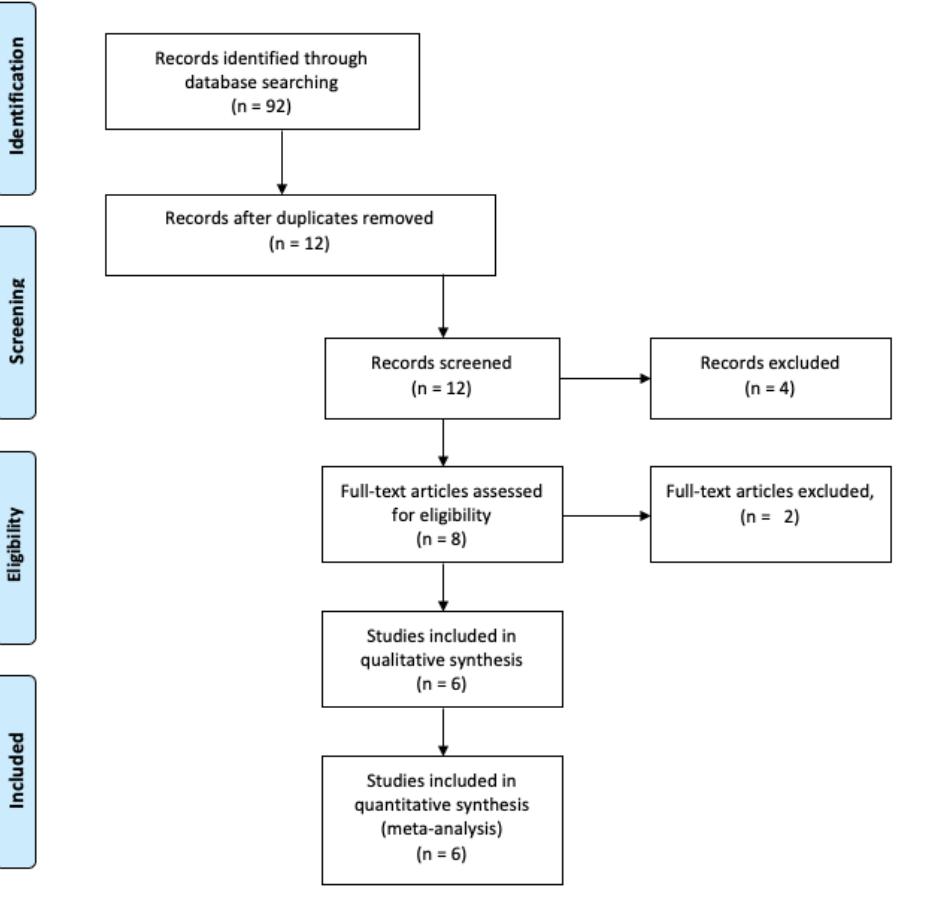
Figure 1. Study selection flow diagram. Table 2. Included reviews arranged according to timeline of publication with their